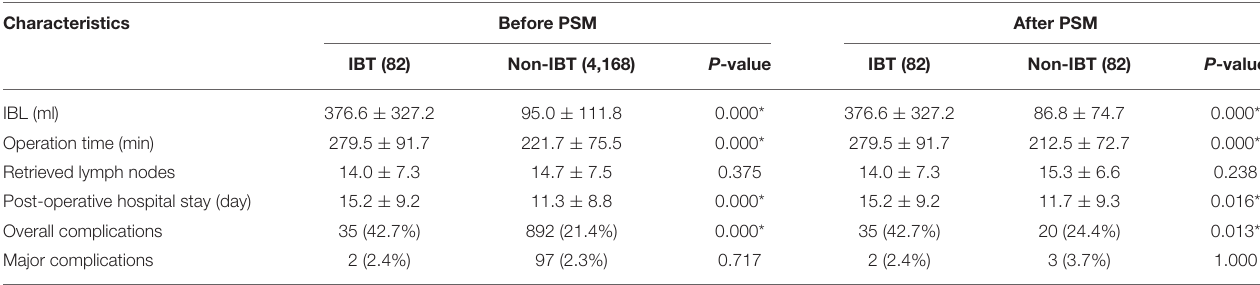
TABLE 6 | Short-term outcomes before and after